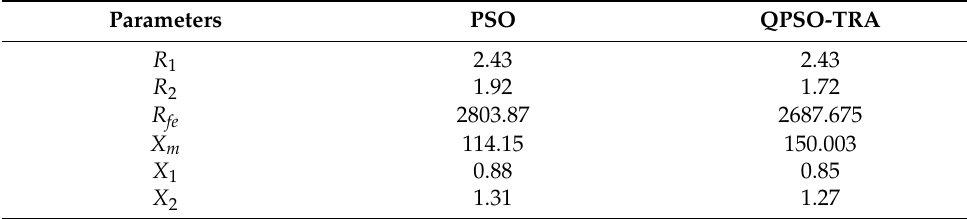
Table 4. 5.5 kW motor estimated efficiencies and speeds versus measured in the laboratory. Table 3. Comparison of determined parameters of 5.5 kW motor.